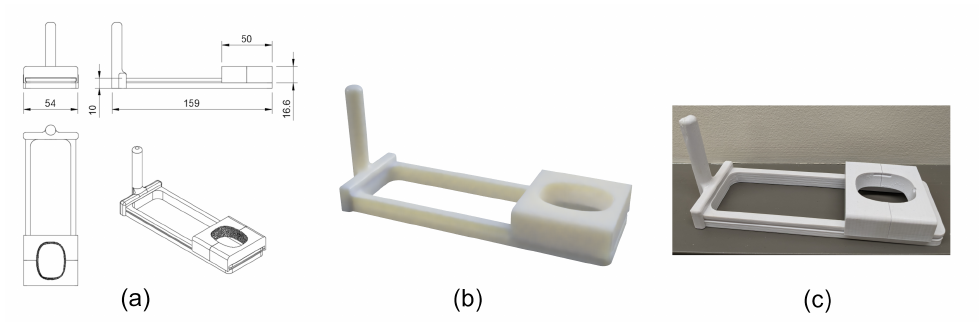
Figure 3. Mechanical slide fixture allowing 1-D movement along the array dimension. ( a ) Dimen- sioned diagram (units mm). ( b ) Rendering. ( c ) 3-D printed